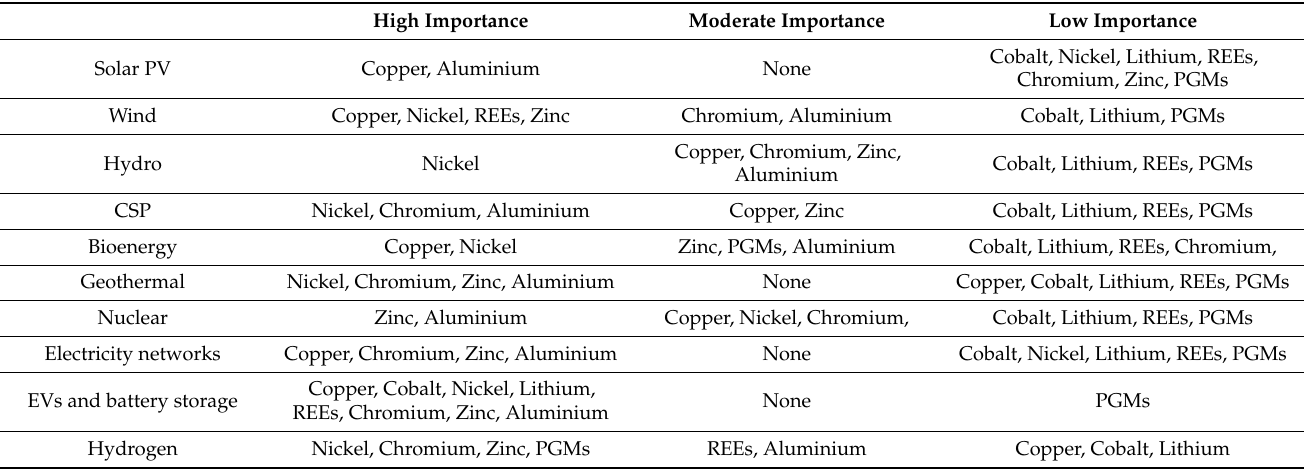
Table 1. The role of primary minerals in clean energy (Data Source: [5]).